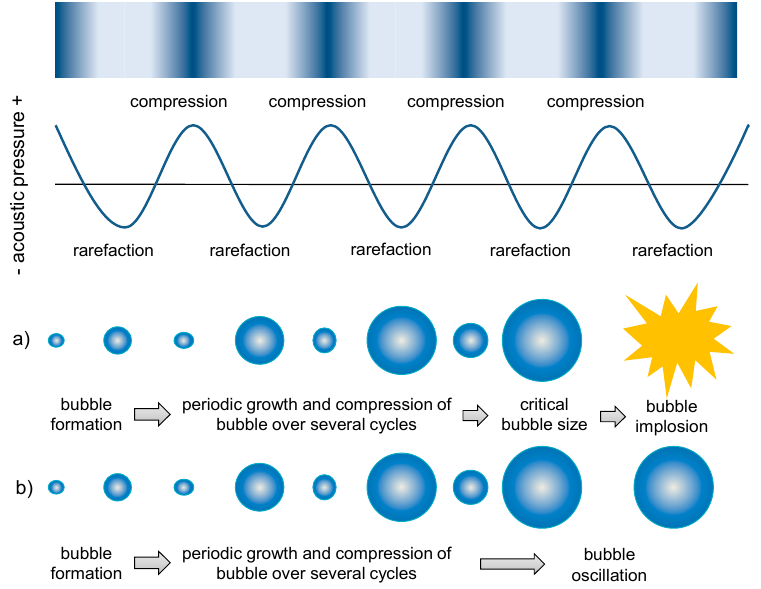
Figure 3. Schematic depiction of ( a ) inertial and ( b ) stable cavitation (reprinted with modifications from [51], SPringer, by permission from Springer: Izadifar et al. (2018) [51])